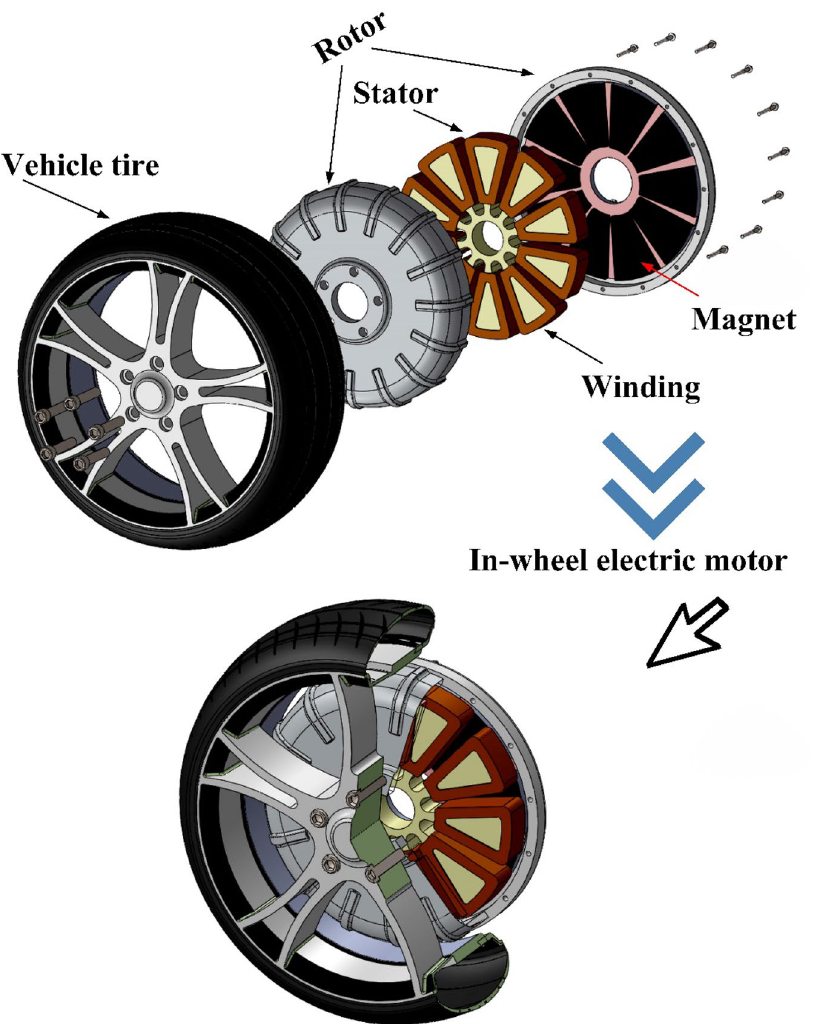
Figure 1. In-wheel constructed AFPMS motor for electric vehicle